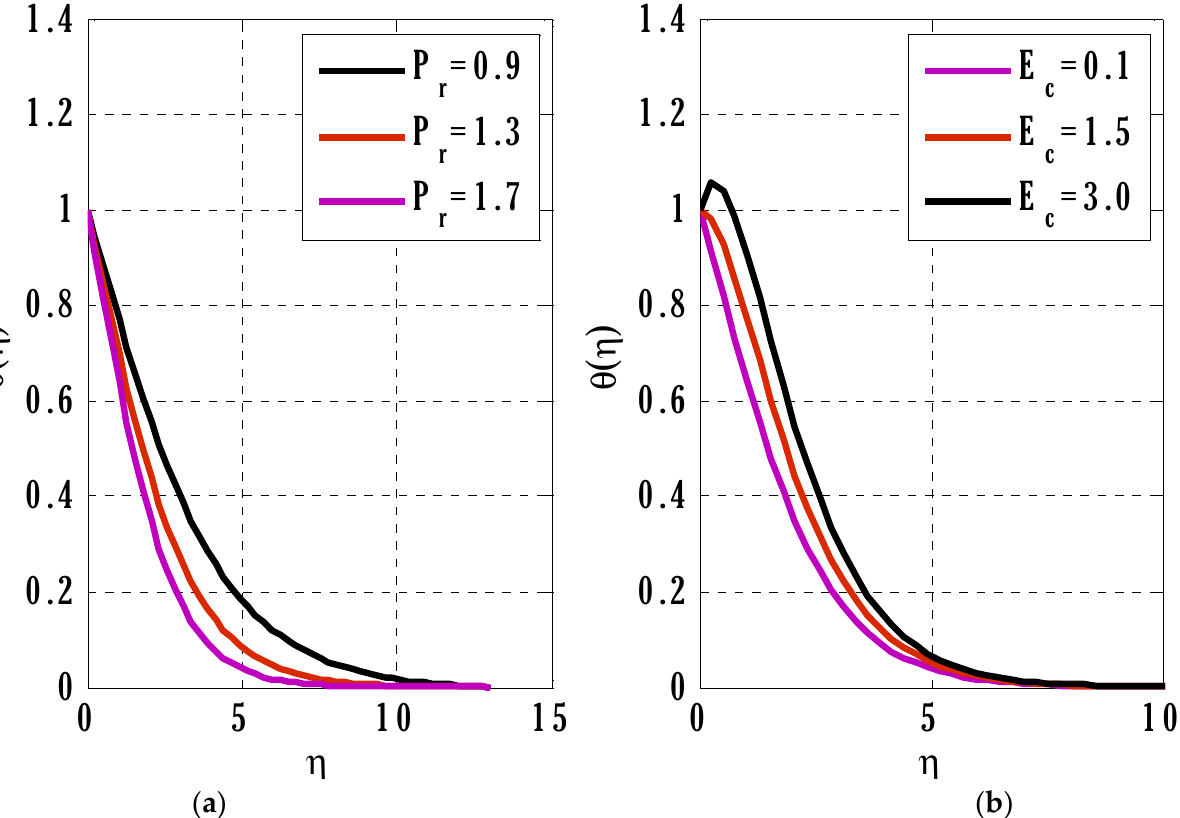
Figure 4. Variation of Prandtl number and Eckert number on temperature profile using β = 3, M = 0.1, λ = 0.1, F r = 0.1, N t = 0.1, S c = 1.5, N b = 0.1, R d = 0.9, E 1 = 0.01, ε 1 = 0.9, ε 2 = 0.5, γ = 0.1. ( a ) E c = 0.1 ( b ) P r =